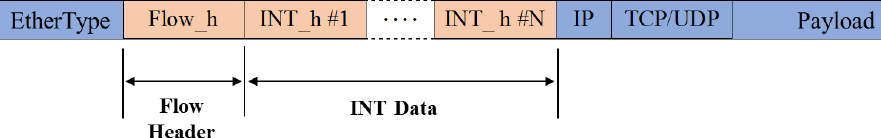
Figure 7. SDNPS data packet format.